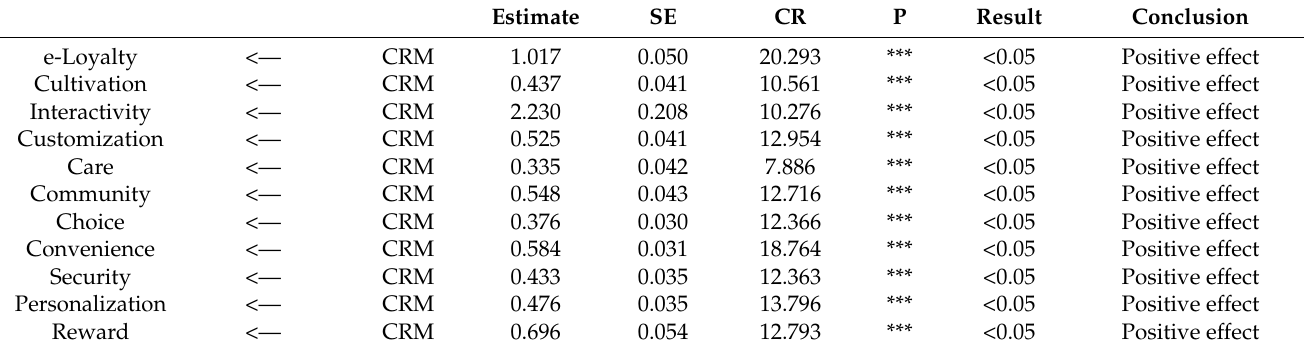
Table 4. Structural Equation Modeling Model (SEM-Model) results.